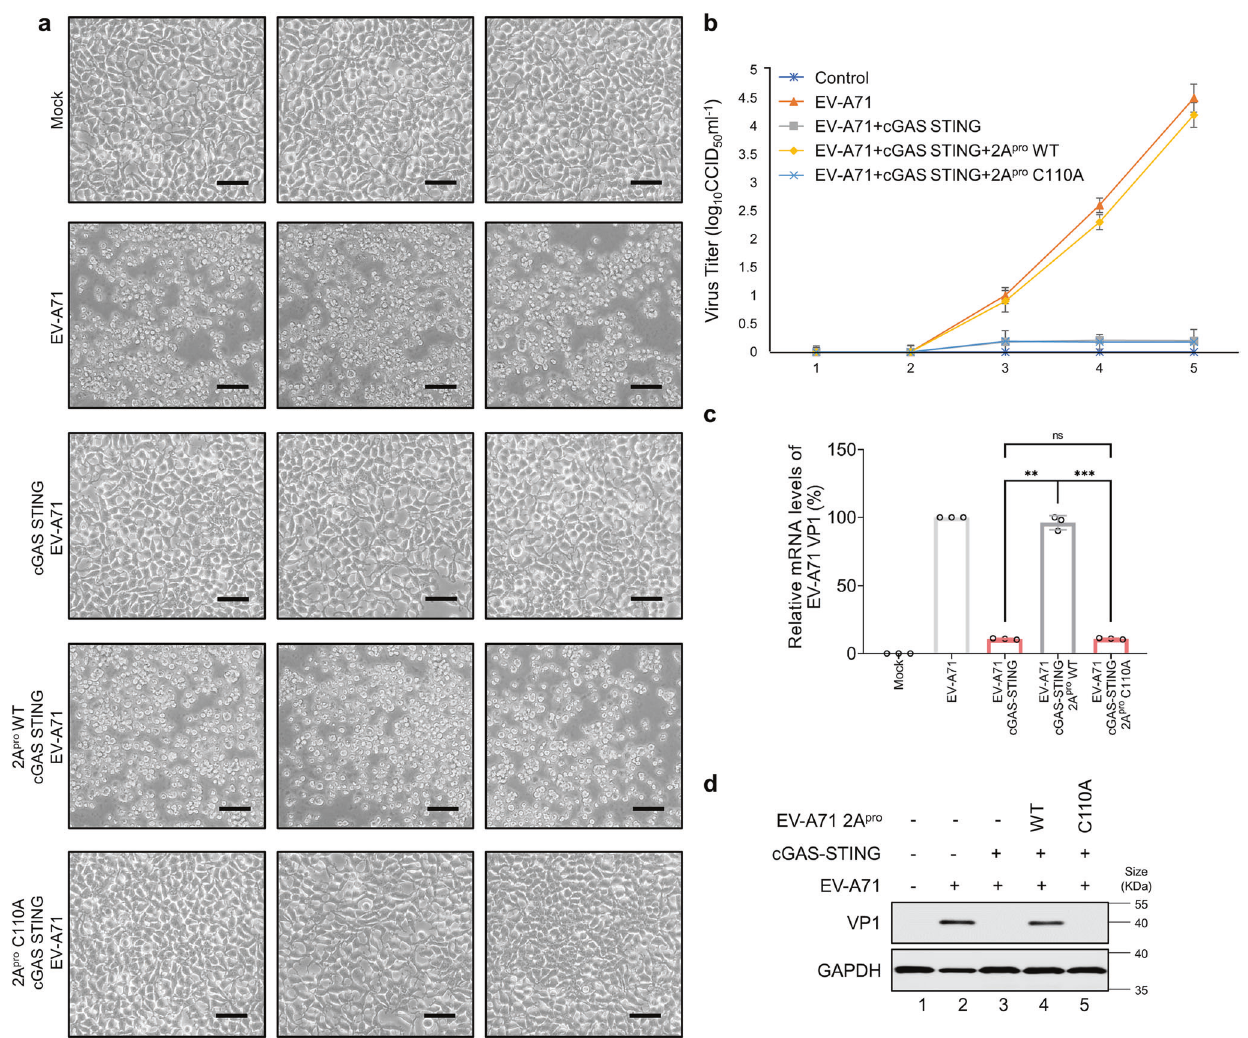
Fig. 6 2 A pro of EV-A71 inhibits the anti-viral function of cGAS-STING activation. a CPE induced by EV-A71. HEK-293T cells were transfected with empty or cGAS-STING-expressing vectors in the presence or absence of exogenous EV-A71 2A pro WT or C110A. Twelve hours later, the cells were infected with equal amounts (MOI of 0.5) of EV-A71 for 6 h. The cells were then washed and incubated with fresh culture medium. Five days later, the cells were observed for morphological changes and photographed using light microscopy at 400 × magni fi cation. Scale bar represents 50 μ m. b EV-A71 from HEK-293T cells was collected on days 1 – 5 after infection (A). The viral titer was determined using CCID50 assays. c The viral RNA levels of EV-A71 were evaluated by RT-qPCR using SYBR green. Primers targeted EV-A71 VP1 to monitor viral replication. GAPDH abundance was used as a control. d EV-A71 from HEK-293T cells was collected on day 5 after infection for western blot. Cell lysates were separated by SDS-PAGE, transferred to PVDF membranes, and treated with the indicated antibodies to detect EV-A71 VP1 and GAPDH. GAPDH was used as a loading control. Data in a – c represents the average of results from three independent experiments ( n = 3, representative immunoblots are shown). Error bars indicate the standard deviation of the data from three independent experiments. Means and standard deviations are presented. Statistical signi fi cance was determined using two-sided unpaired t -test, * p < 0.05; ** p < 0.01; *** p < 0.001; **** p <